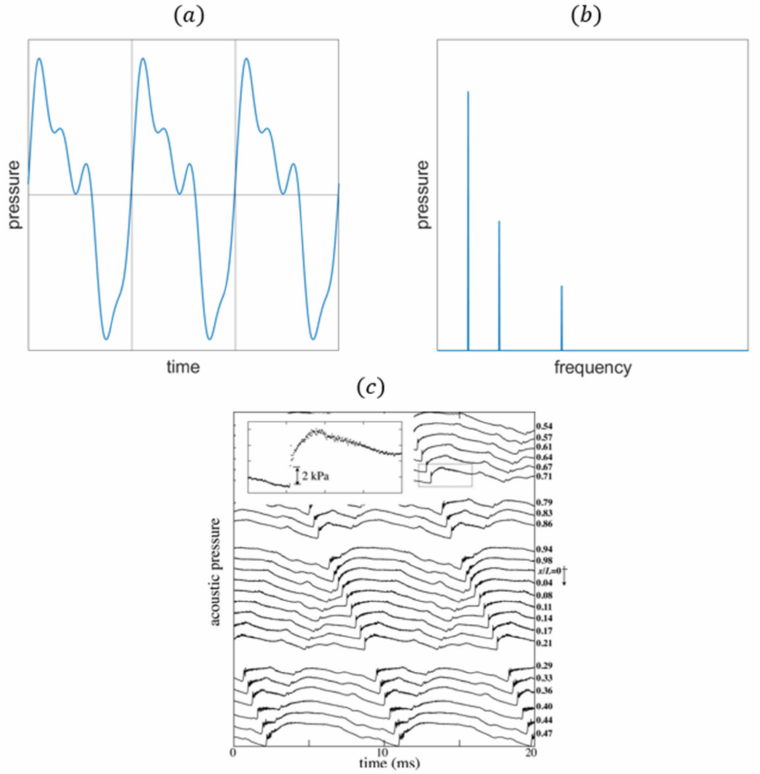
Figure 3. Harmonics in the time domain ( a ) and frequency domain ( b ), and shock waves ( c )